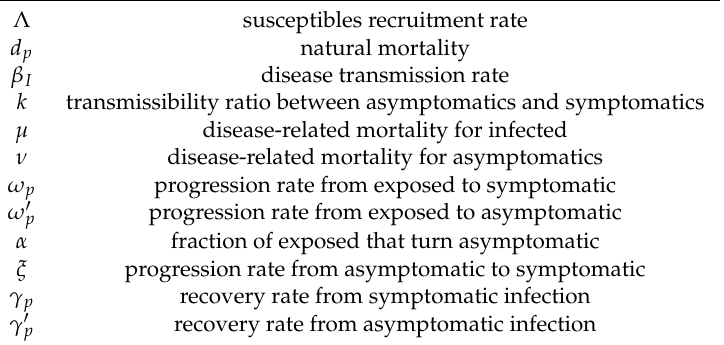
Table 4. Model parameters and their